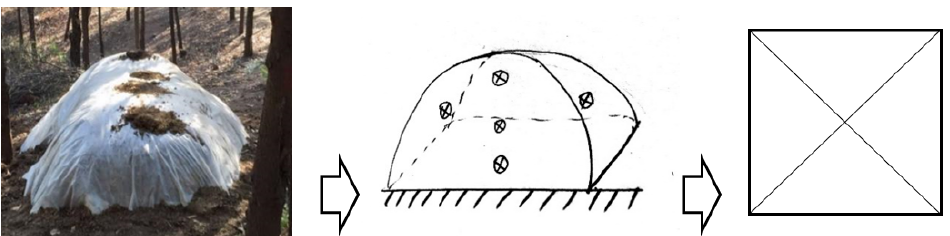
Figure 1. Sample collection. From left to right are photos of composting in Platycladus orientalis (L.) Franco, location of 5 sampling points of mixed samples, and collection of compost mixed samples by quartering method.